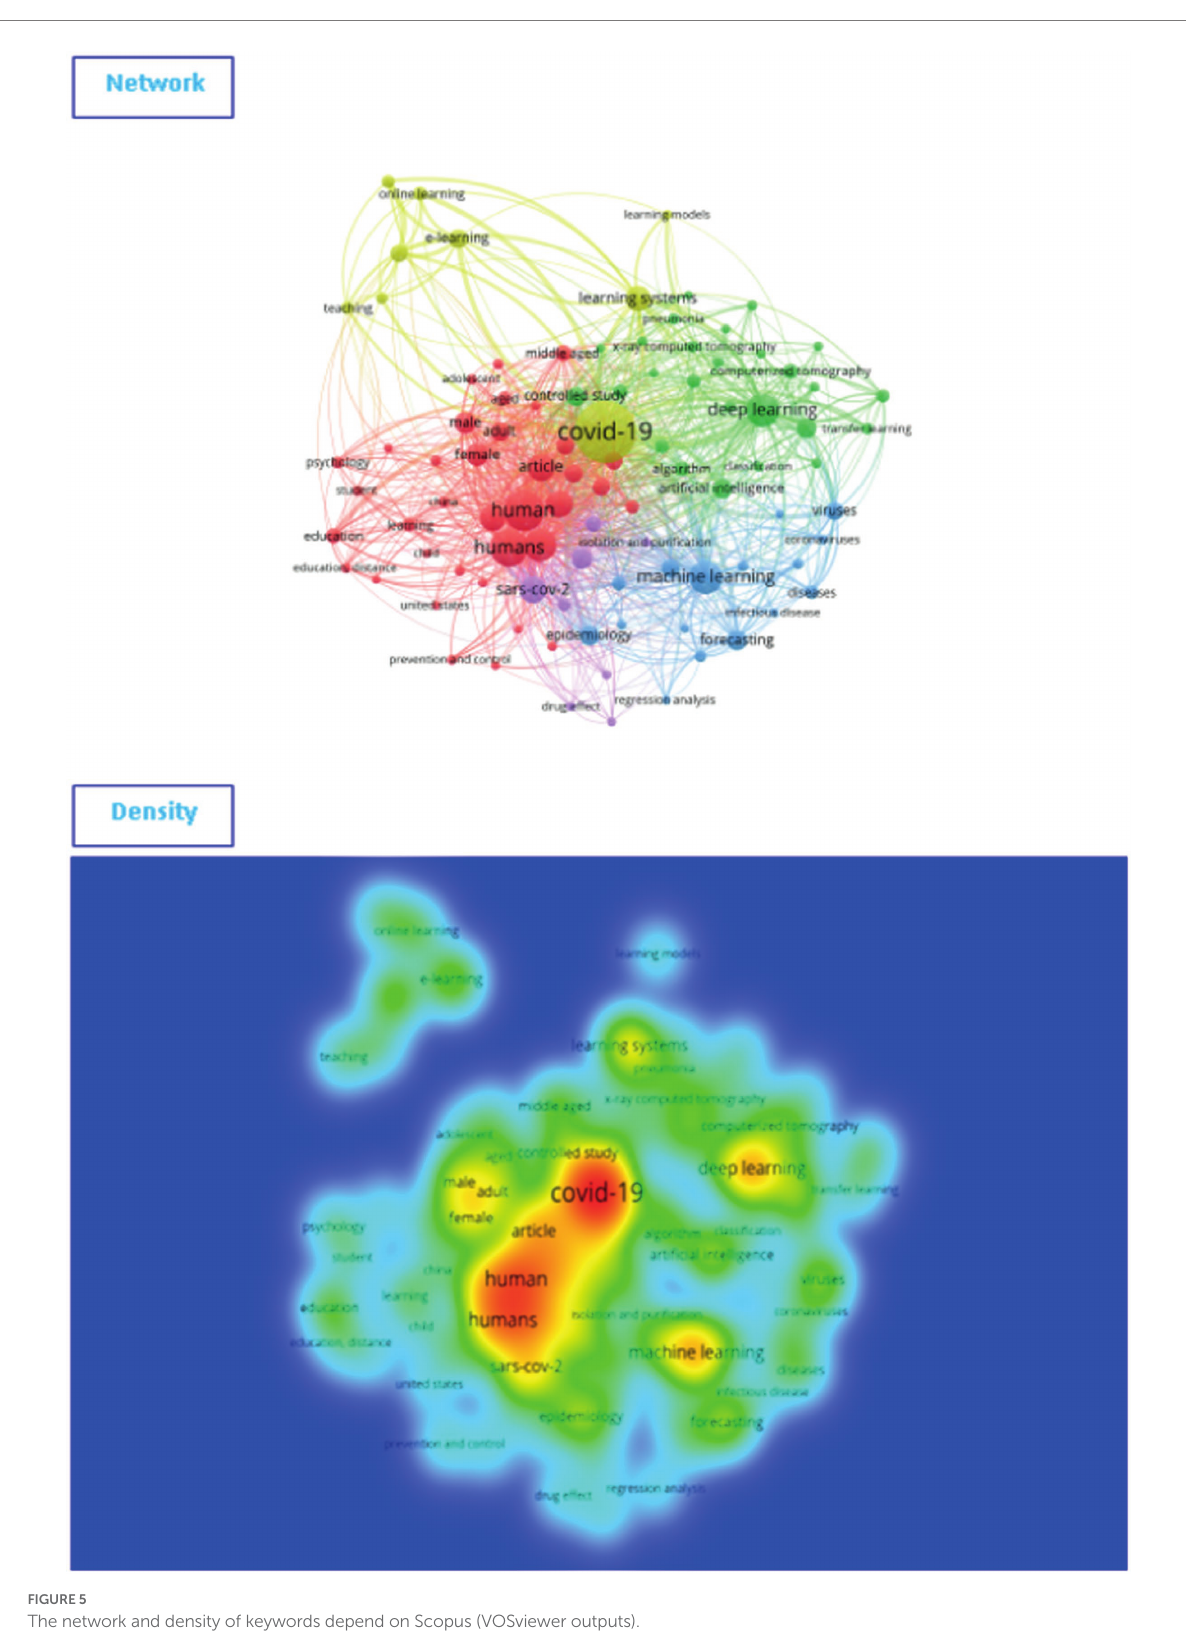
FIGURE 5 The network and density of keywords depend on Scopus (VOSviewer